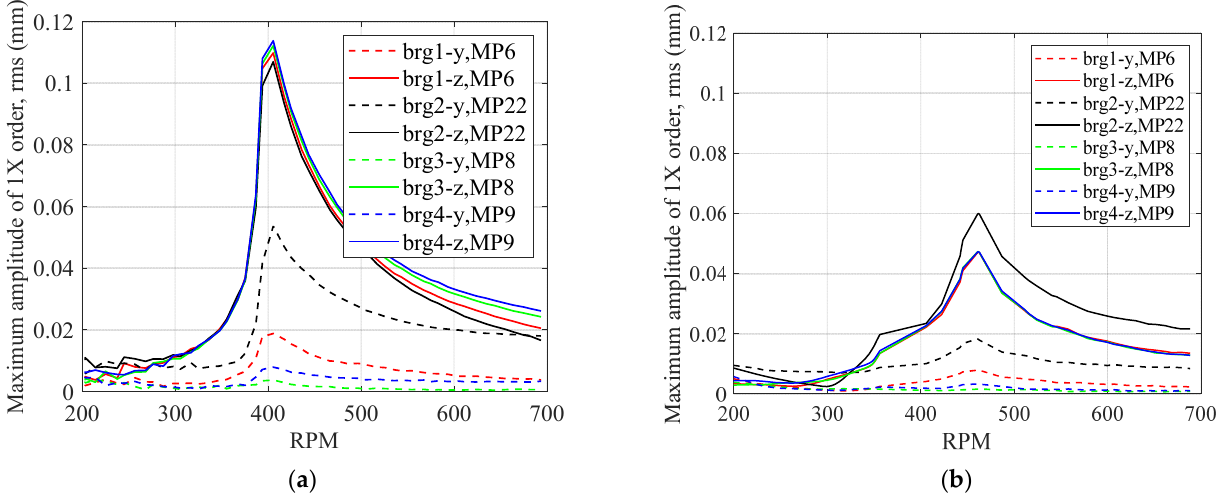
Figure 11. Campbell diagram.